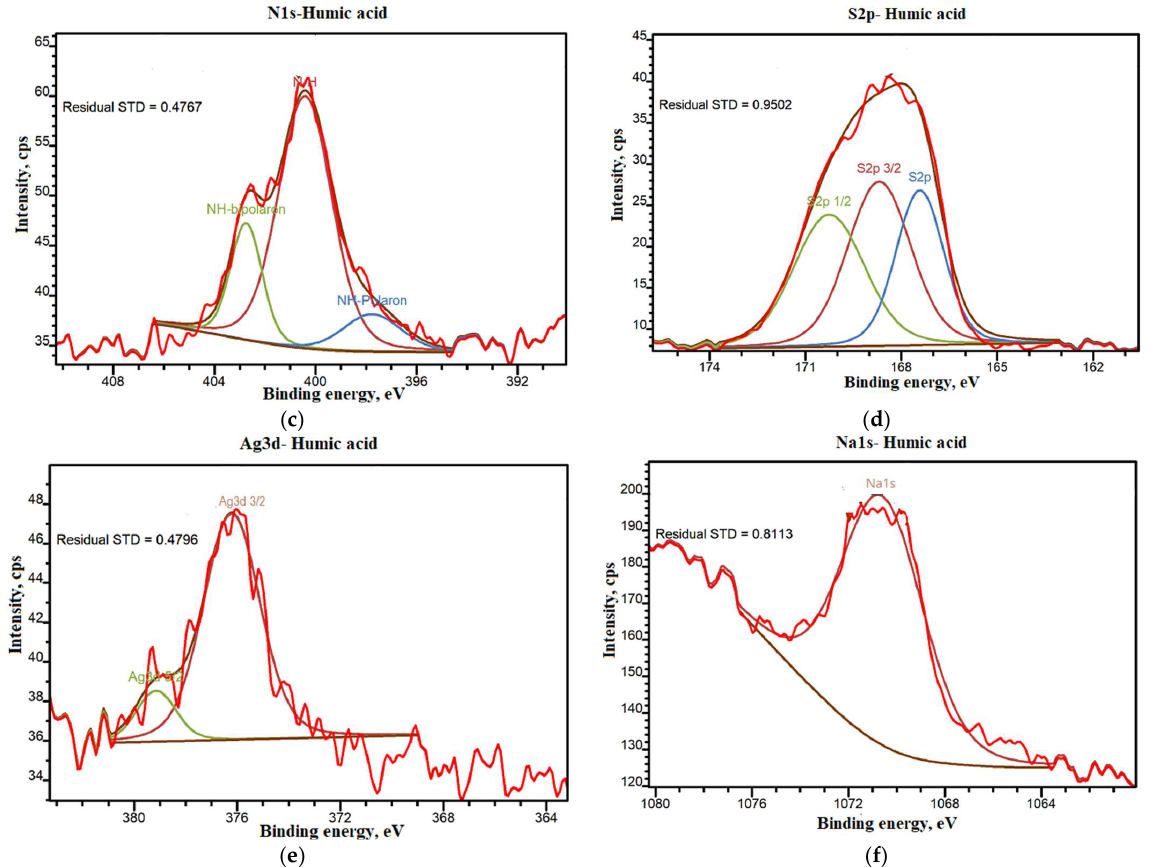
Figure 8. XPS analysis outcomes for humic acid ( a ) C1s; ( b ) O1s; ( c ) N1s; ( d ) S2€; ( e ) Ag3d and ( f )